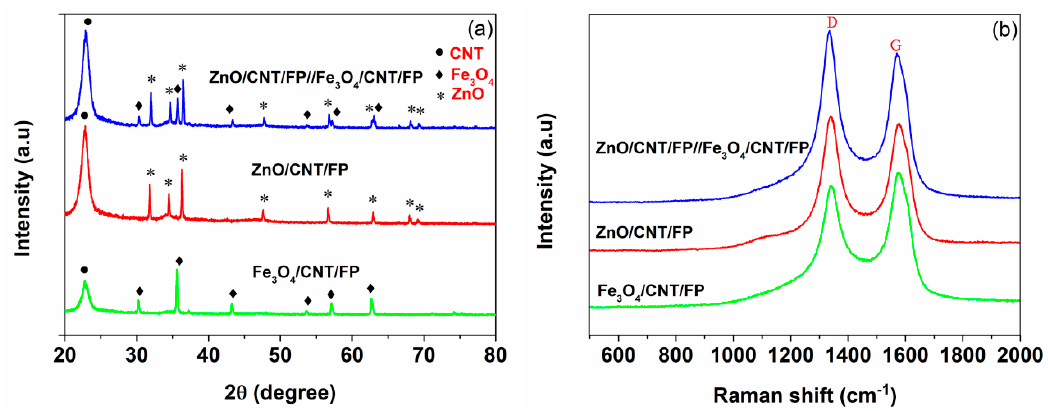
Figure 2. ( a ) XRD patterns of ZnO / CNT / FP, Fe 3 O 4 / CNT / FP and ZnO / CNT / FP / Fe 3 O 4 / CNT / FP composites, respectively; ( b ) Raman spectra of ZnO / CNT / FP, Fe 3 O 4 / CNT / FP and ZnO / CNT / FP // Fe 3 O 4 / CNT / FP composites, respectively.